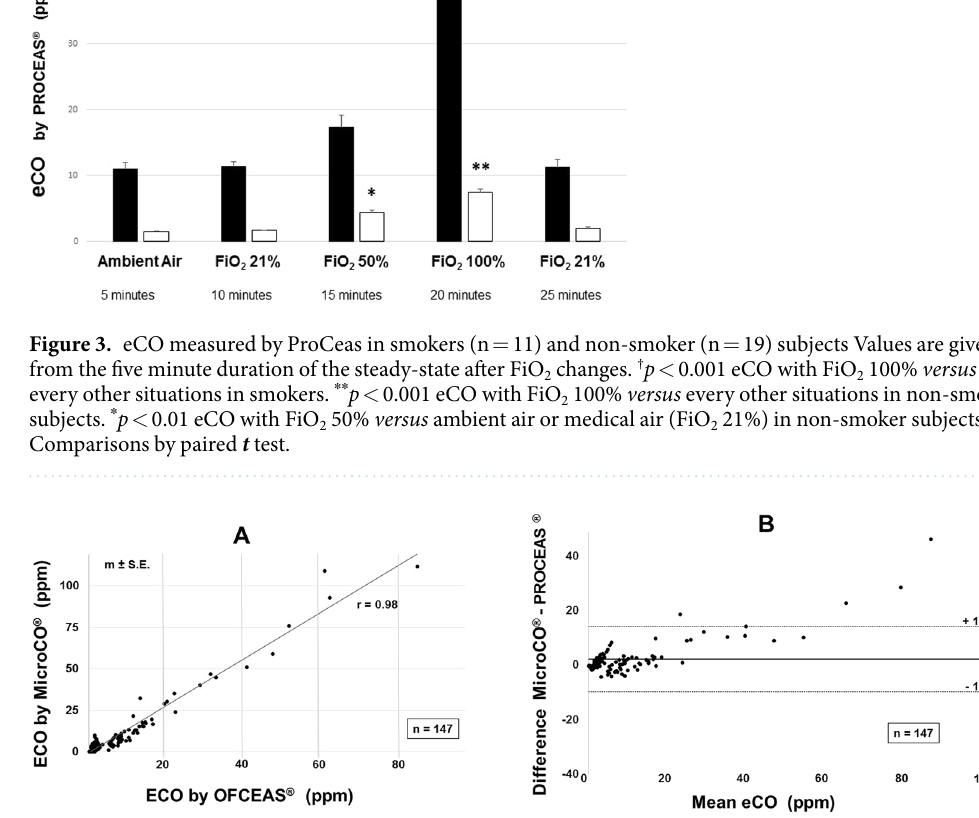
Figure 4. ( A,B ) Comparison of ProCeas and MicroCO measurements. ( A ) Correlation scatter plot; correlation represents the relationship between dataset; correlation coefficient is given as r . ( B ) Bland-Altman plots; eCO are given in ppm; vertical axis shows the eCO difference between the compared devices; mean eCO on the horizontal axis refers to the average of the eCO values measured by both